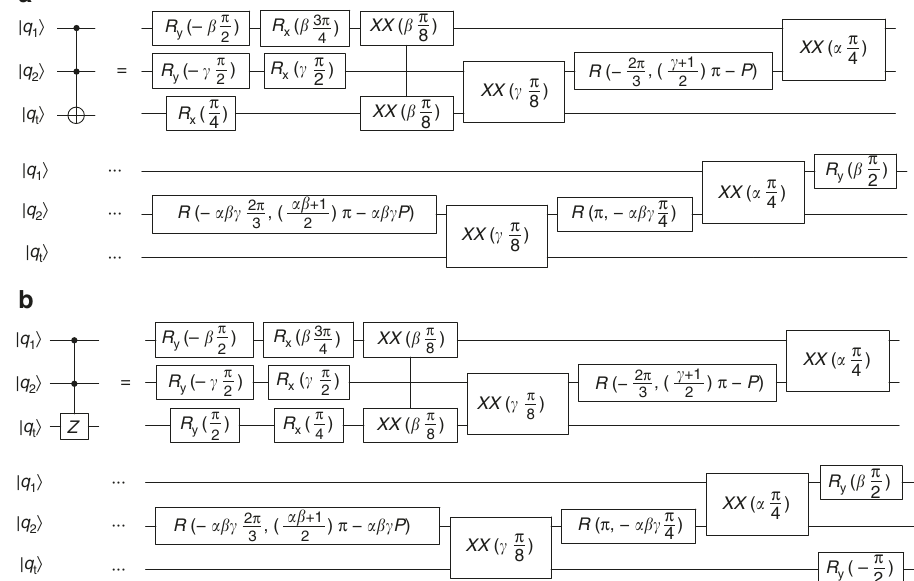
ffiffi q(cid:3) (cid:4) Fig. 6 Three-qubit composite gates. Three-qubit composite gates using XX ( χ ), R x ( θ ), R y ( θ ), and R ( θ , ϕ ) gates. Let α = sgn( χ 12 ), β = sgn( χ 1t ), γ = sgn( χ 2t ), and P ¼ arcsin 2 . a Toffoli-3 gate implementation. b Controlled-controlled- Z ( CCZ ) gate implementation 3